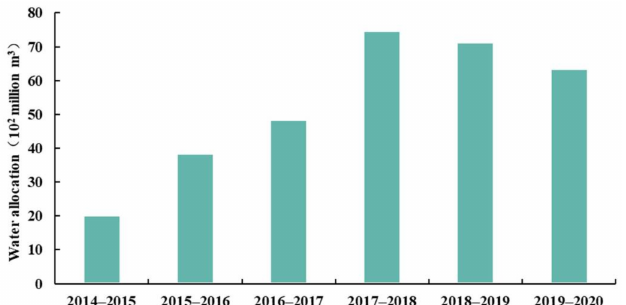
Figure 3. Annual water allocation for four provinces (Beijing, Tianjin, Hebei, and Henan) of SNWD.